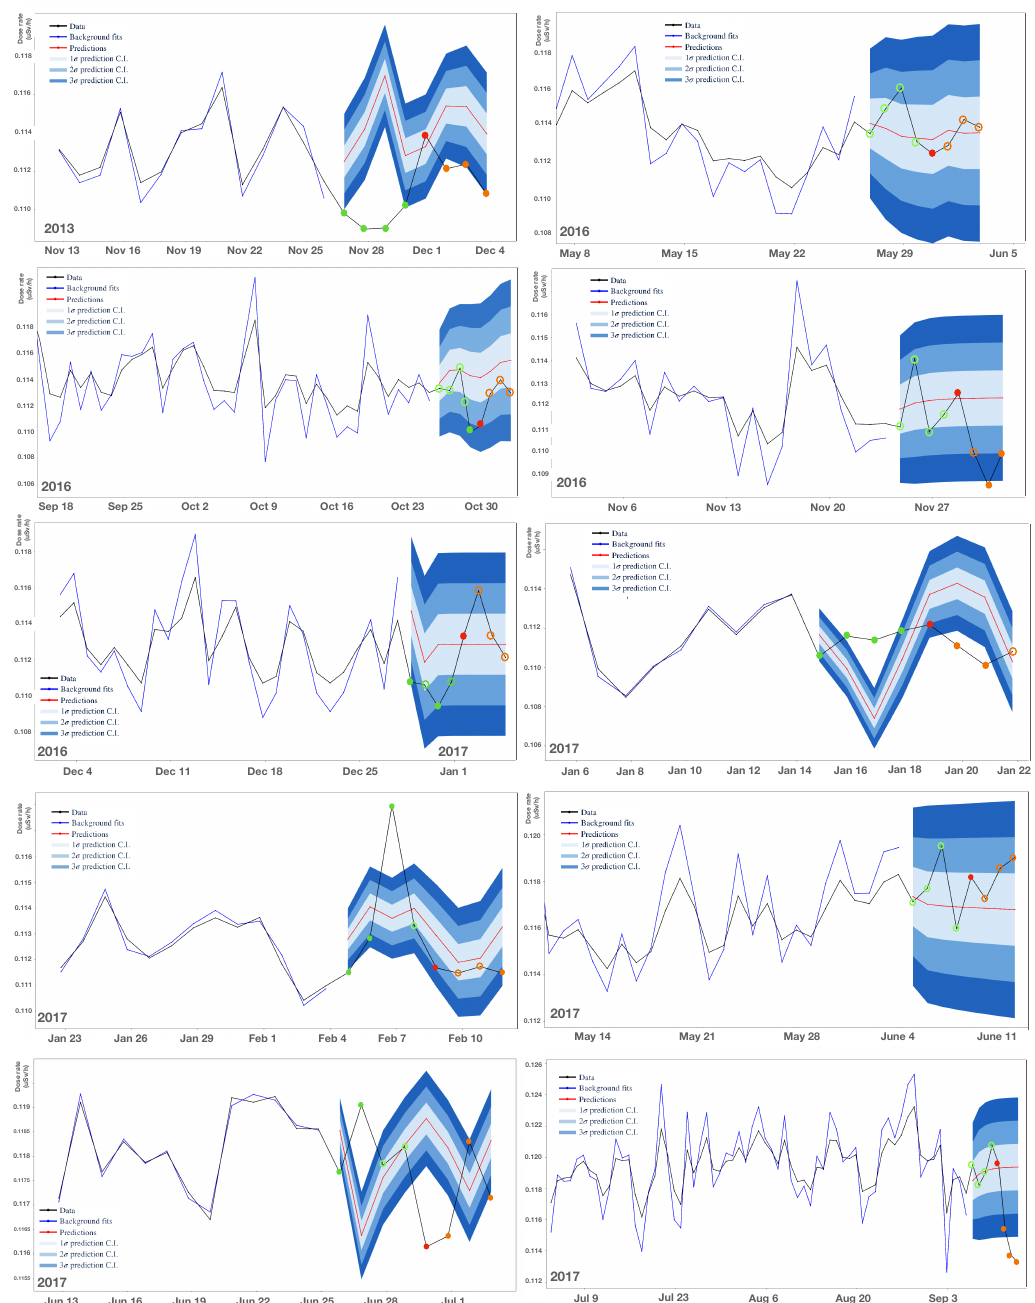
Figure 6. Results of the ARFIMA model forecasting in the blind time-regions defined around the seismic events of interest (color on-line). The solid black line represents the daily averaged dose rate data, the blue line corresponds to the fit results using the ARFIMA model, and the red line is the ARFIMA prediction in the blind time region. For the blind time regions, the confidence level bands for coverage factor k = 1, 2, 3 (from the lightest to the darkest blue, color on-line) are drawn. Solid (empty) green markers represent data before the earthquake that deviate more (less) than 2 σ from the prediction. The red solid circle represents the earthquake event and the solid (empty) orange markers represent data after the earthquake that deviate more (less) than 2 σ from the prediction. The time series for the seismic event registered on 20 February 2017 is not reported in the figure because the background series was too brief (three days) to build a reliable ARFIMA